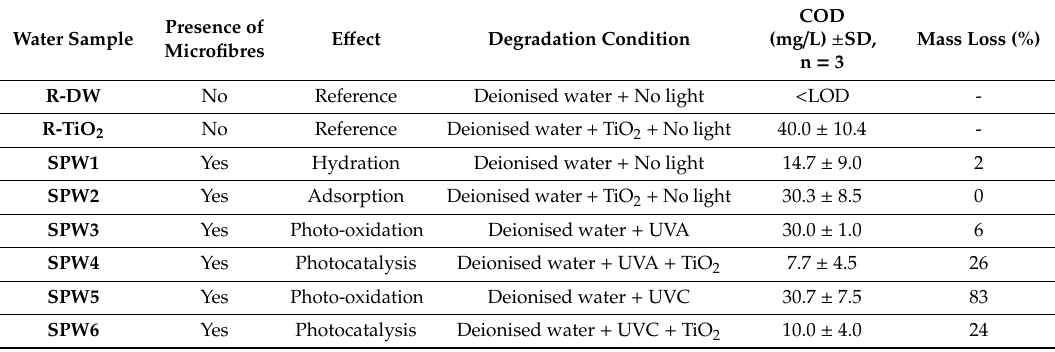
Table 7. The COD of the water were the PA66 microfibres were suspended and exposed to the di ff erent conditions of UV and catalyst (SPW1–SPW6). R-DW refer to the reference water sample; R-TiO 2 refers to 20,000 mg / L of TiO 2 in water without UV irradiation. COD results were averaged from the triplicate